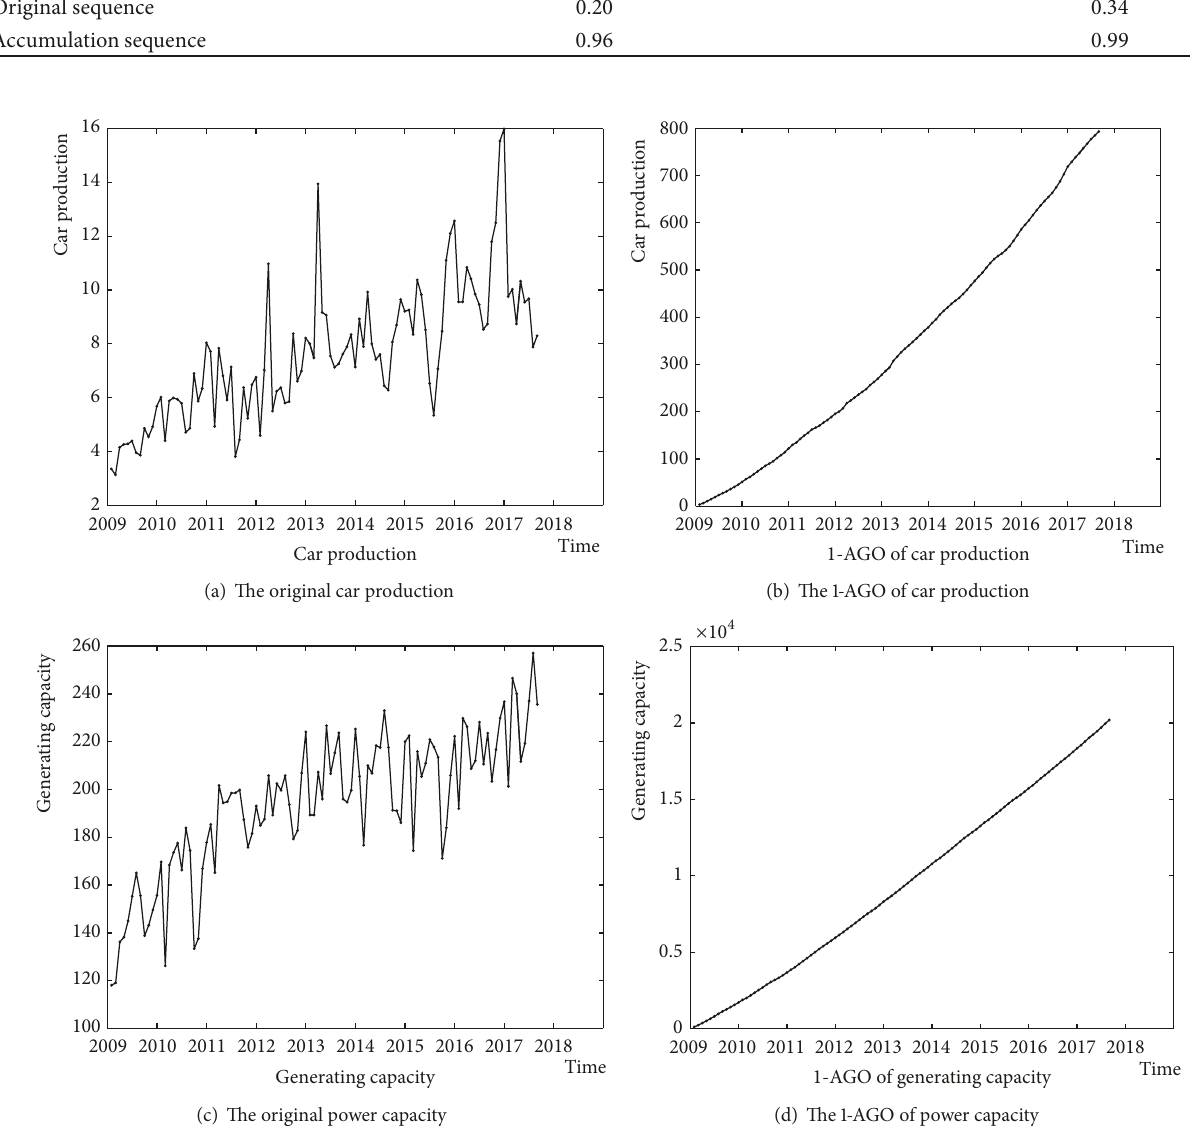
Figure 5: The original value and one order accumulation value for two